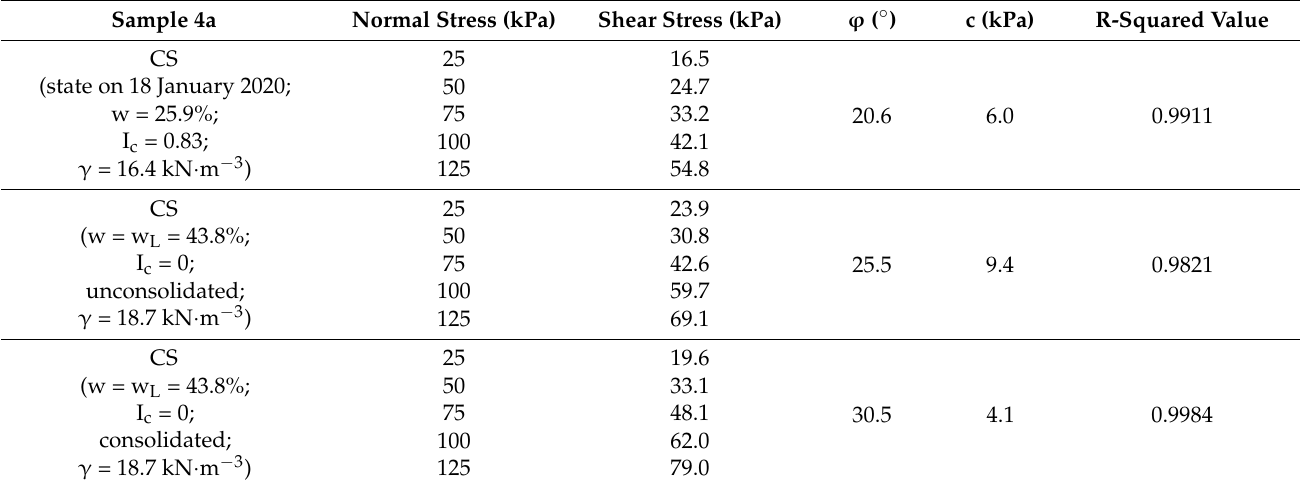
Table 2. Water content, unit weight, and shear strength parameters of soil sample 4.